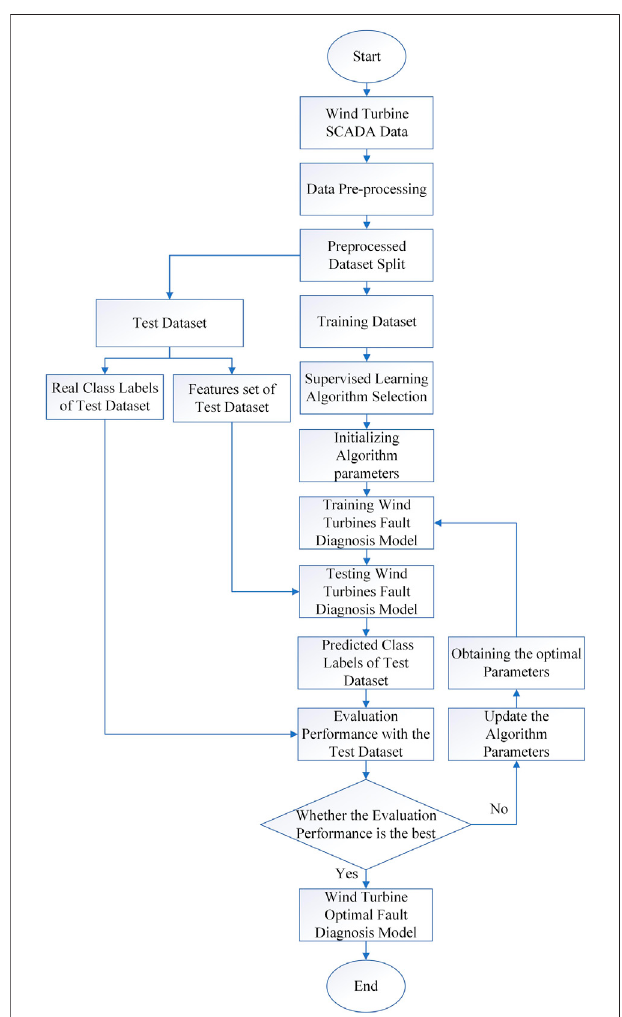
FIGURE 4 | Flowchart of WT fault diagnosis based on the supervised Learning